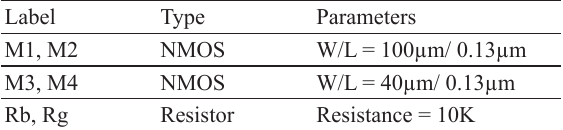
Circuit parameter for series shunt T/R switch.